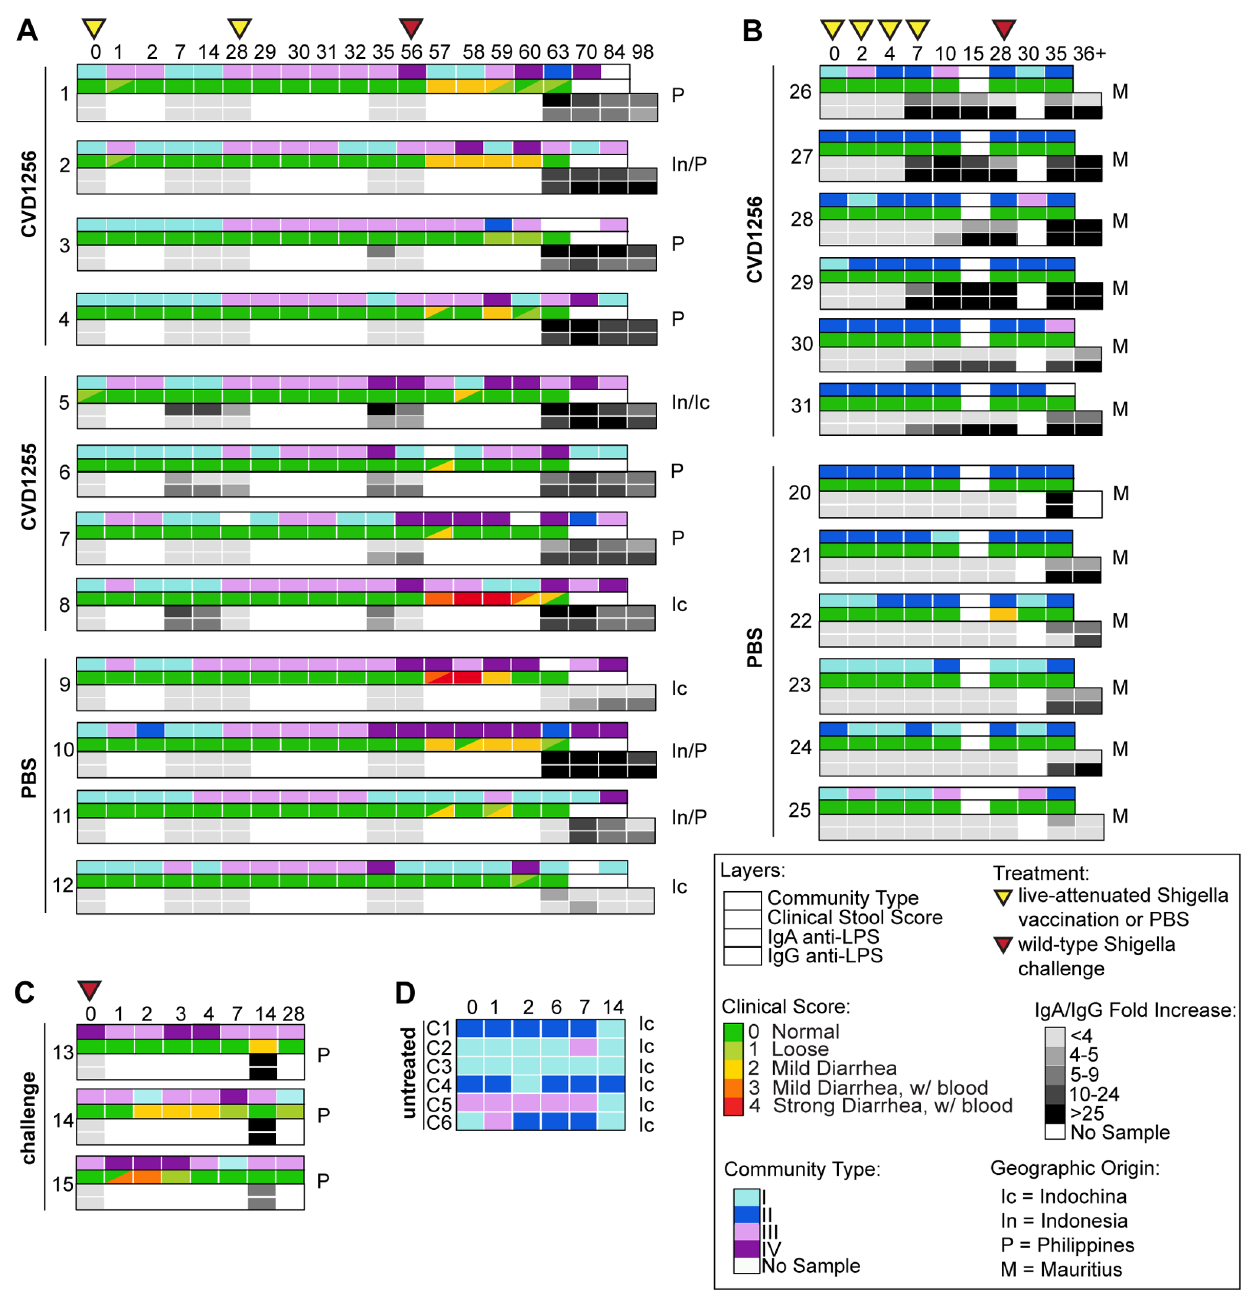
Figure 6. Effect of Shigella strains on the fecal microbiota in cynomolgus macaques. Community type composition, clinical disease symptoms, and elicited immune response over time for ( A ) study 1, ( B ) study 2, ( C ), study 3, and ( D ) study 4. Individual macaque identification and treatment administered (CVD1255, CVD1256 or PBS) are indicated on the y-axis (left), with geographic origin of each macaque on the right. Sampling day is indicated on the x-axis, with color-coded arrows (immunization or challenge) indicating time of treatment (boxed inset). Community type ( A – D ) is indicated on the first top bar, stool severity score ranging from 1 (mild) to 4 (severe) ( A to C ) is indicated on the second bar, and anti-LPS IgA and anti-LPS IgG fold differences over antibody levels before immunization and challenge (day 0) ( A – C ) are indicated on the third and fourth (bottom) bars, respectively, each color-coded according to the boxed inset, with day 0 antibody titers shown the same as , 4 fold increases.